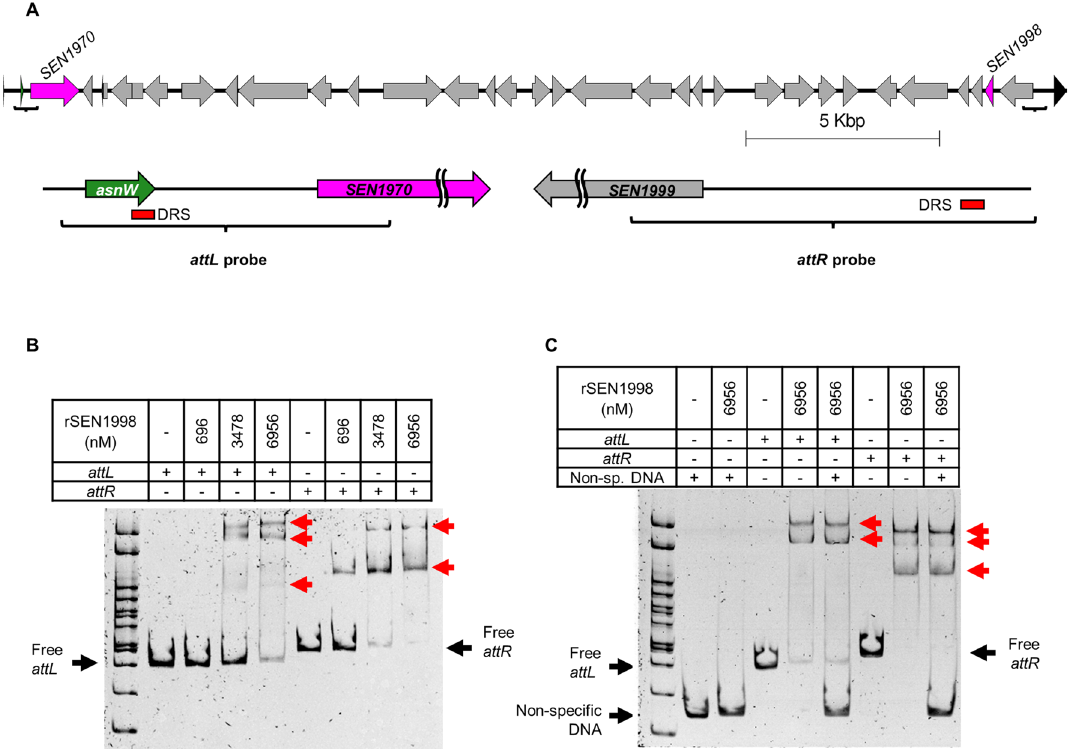
Figure 4. The SEN1998 protein binds the two attachment regions of ROD21 with specificity. ( A ) Schematic representation of the target DNAs encompassing the left and right attachment regions of ROD21 used for the EMSAs. ( B , C ) EMSAs showing the binding of SEN1998 to both att regions, forming different complexes. The black and red arrows indicate the free and complexed target DNA. The multiple cloning site of plasmid pGEM-T Easy was used as a non-specific competitor DNA in C .